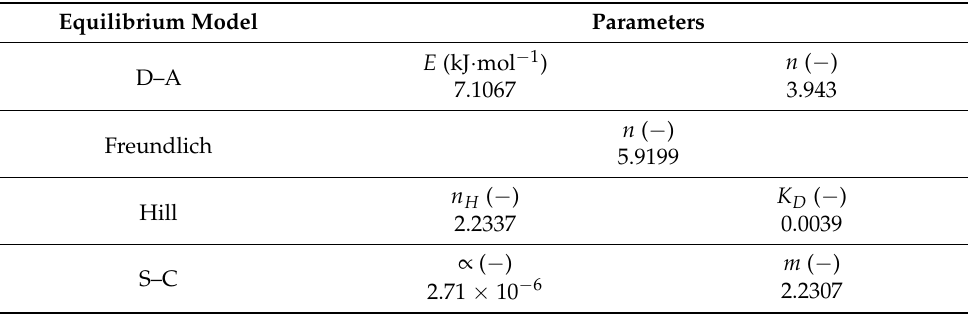
Table 2. SAPO-34 isotherm parameters for different